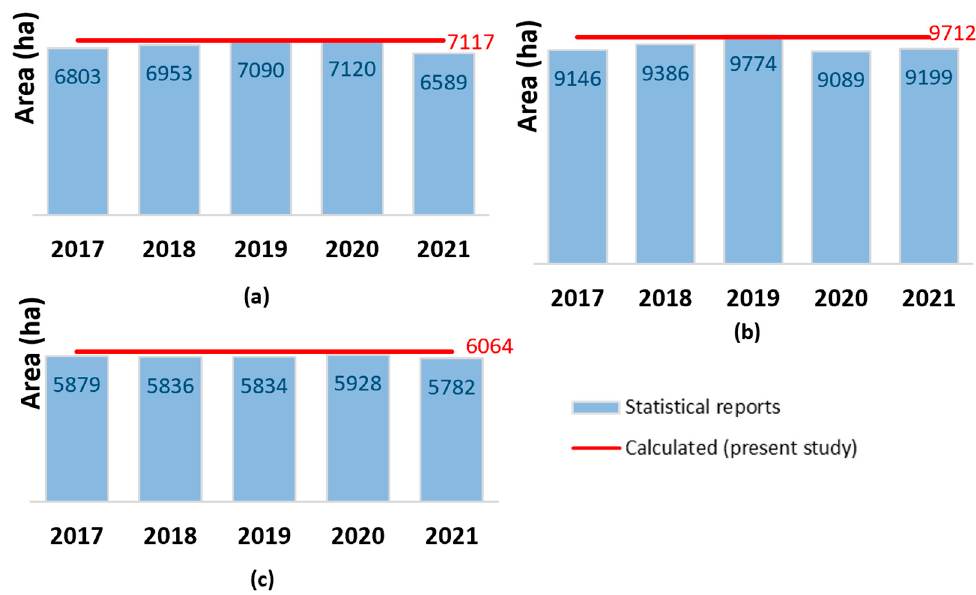
Figure 2. The area of geo-located fi sh ponds in the Shape fi les (presented in the Mendeley dataset) used for our study vs. the area of cultivated fi sh ponds in the annual reports for the region: ( a ) STD, used for our study vs. the area of cultivated fish ponds in the annual reports for the region: ( a ) STD, ( b ) NGP, and ( c ) SGP. ( b ) NGP, and ( c )